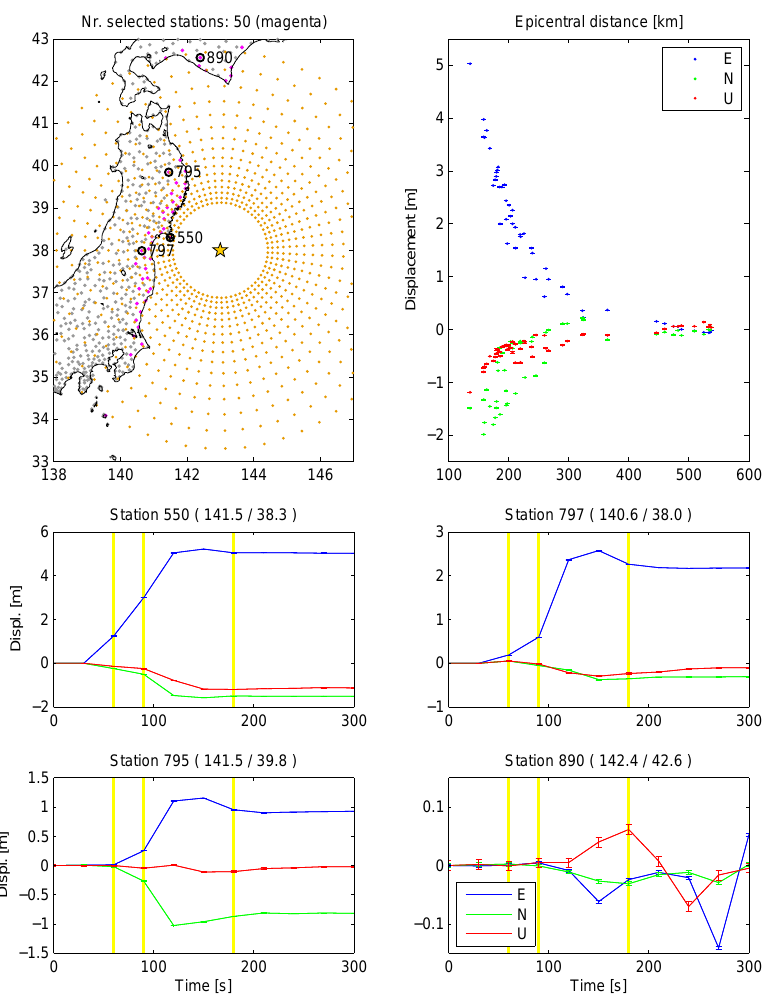
Fig. 1. Upper left panel: grey dots: GEONET stations; magenta: selected stations for real-time inversion; orange: epicentral rays used to select the subset of stations; circles: stations shown in the lower panels. Upper right panel: coseismic displacement as a function of epicentral distance for the selected stations. Lower panels: real-time displacement solutions at 30s sampling interval. The yellow bars indicate the time points for which inversions are shown in Fig.